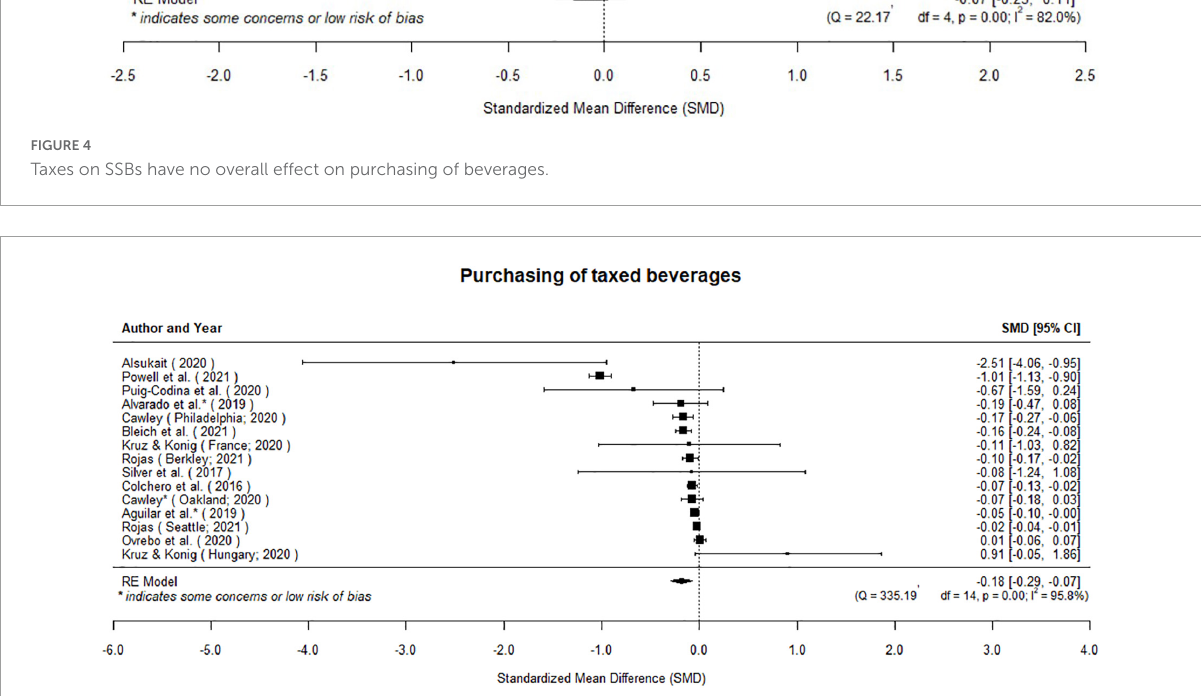
FIGURE5 Taxes on beverages may reduce purchases of taxed